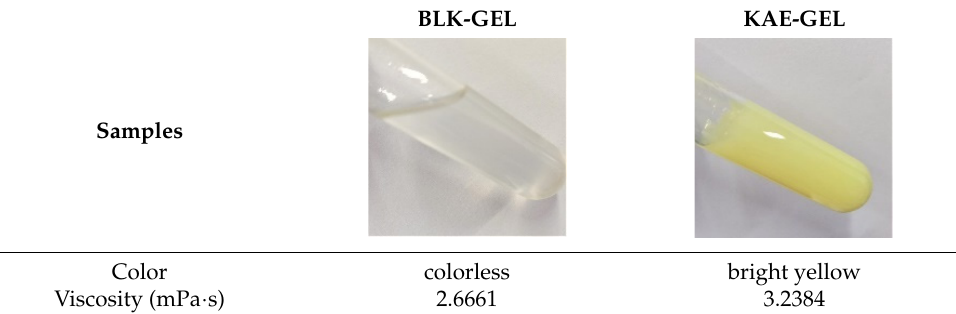
Table 1. Characteristics of KAE-GEL.